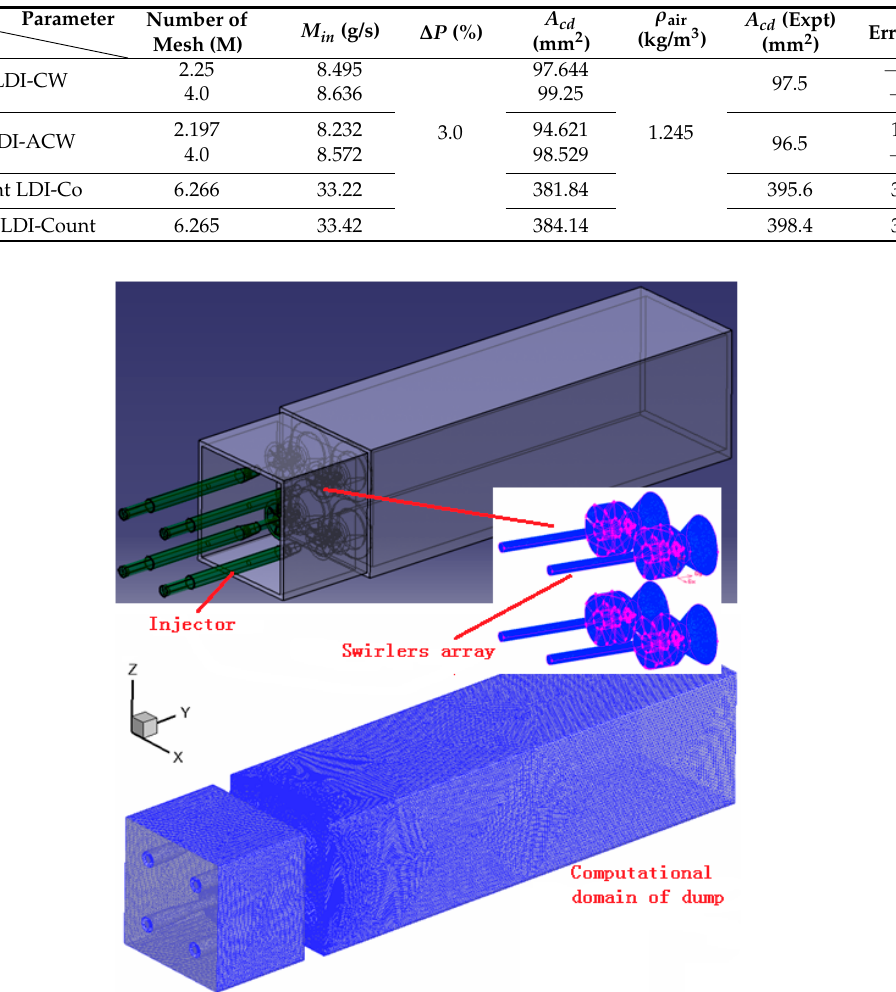
Table 1. Grid-sensitivities for single and four-point LDI combustors with non-reaction flow.